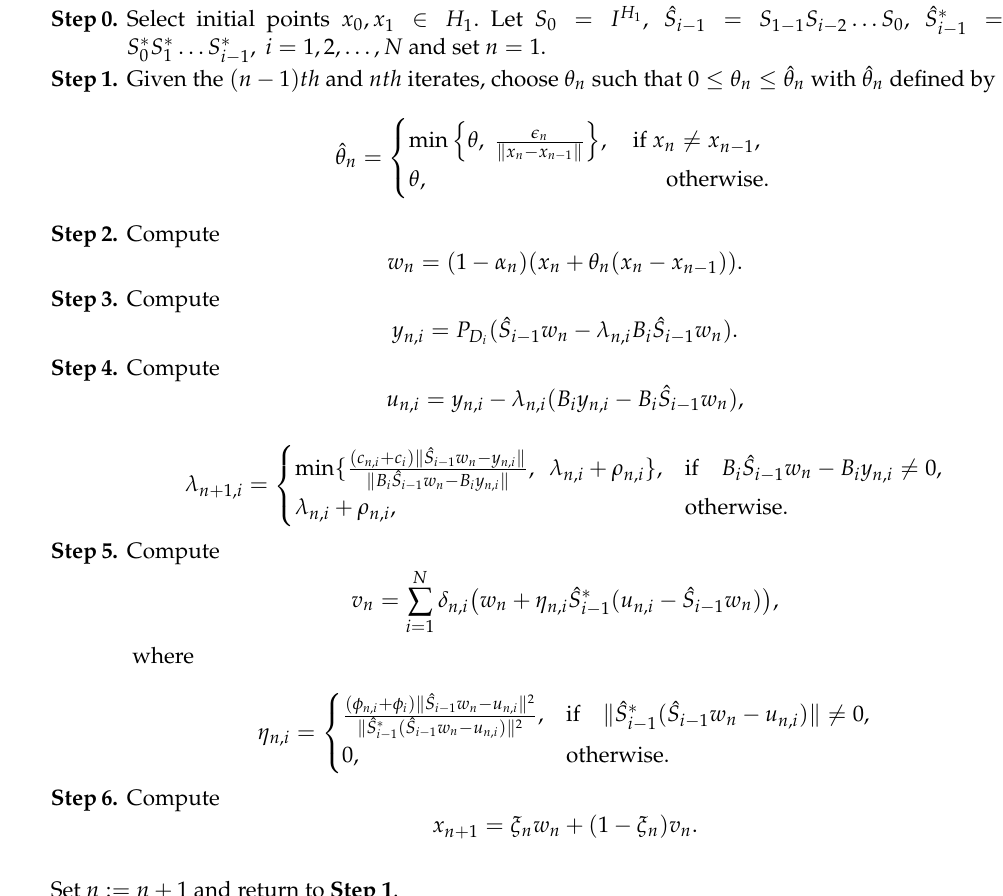
Algorithm 2. A Relaxed Inertial Tseng’s Extragradient Method for Solving GSVIP